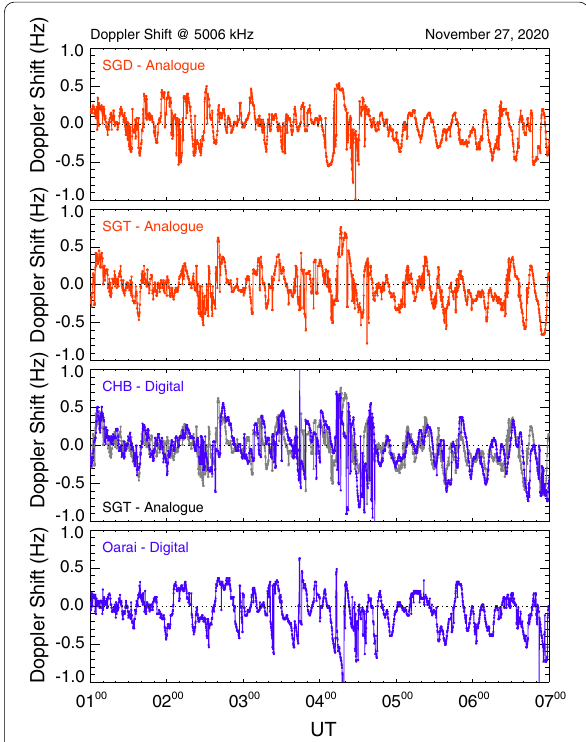
Fig. 11 Observations of MSTIDs on 27 November 2020. The top two panels show the Doppler frequency at 5006 kHz obtained with the analog receivers at SGD and SGT. The bottom two panels show the Doppler frequency at 5006 kHz obtained with the digital receivers at CHB and ORI. The grey line in the third panel (CHB–Digital) shows the Doppler frequency obtained with the analog receiver at SGT as shown in the second